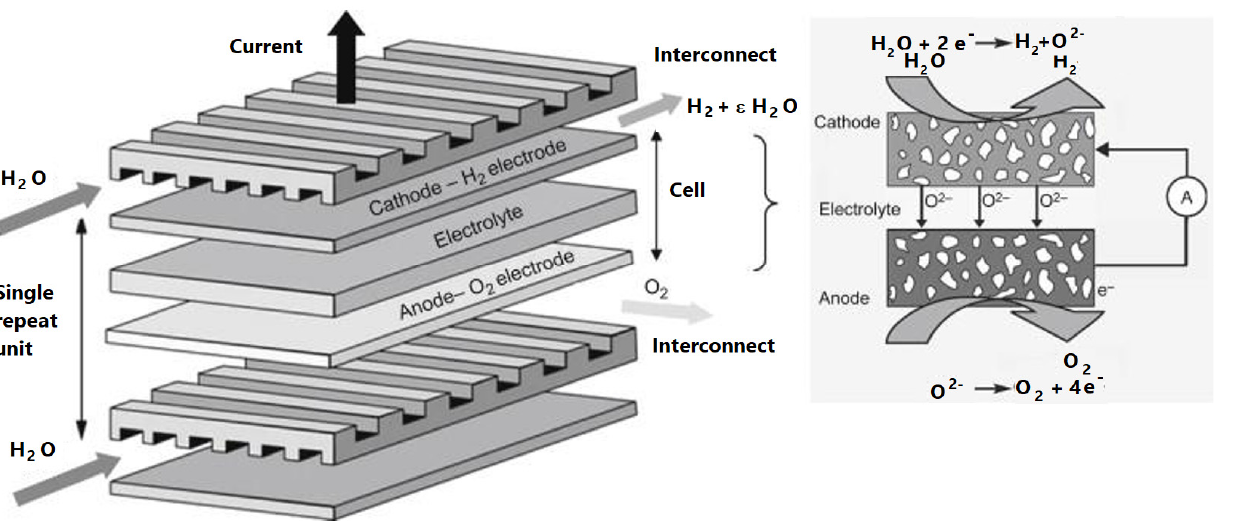
Table 4. Comparison between different methods for hydrogen production based on solar and wind energy.